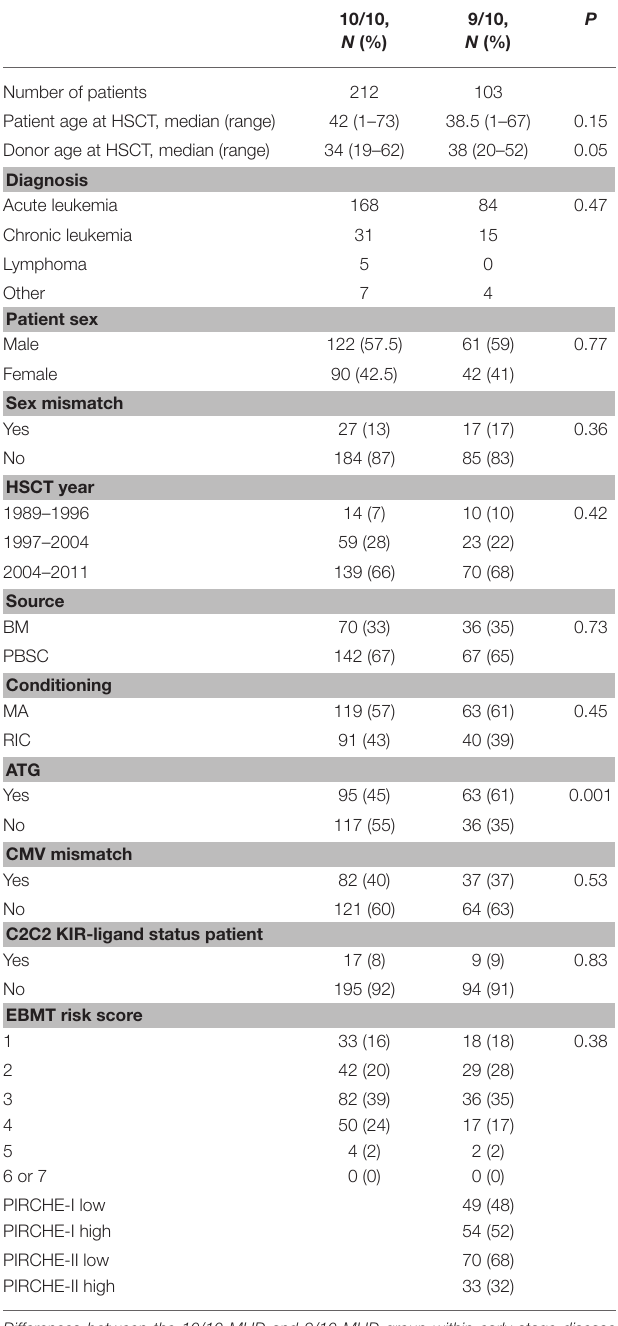
TABLE 2 | Baseline characteristics of 10/10 and 9/10 groups with an early disease